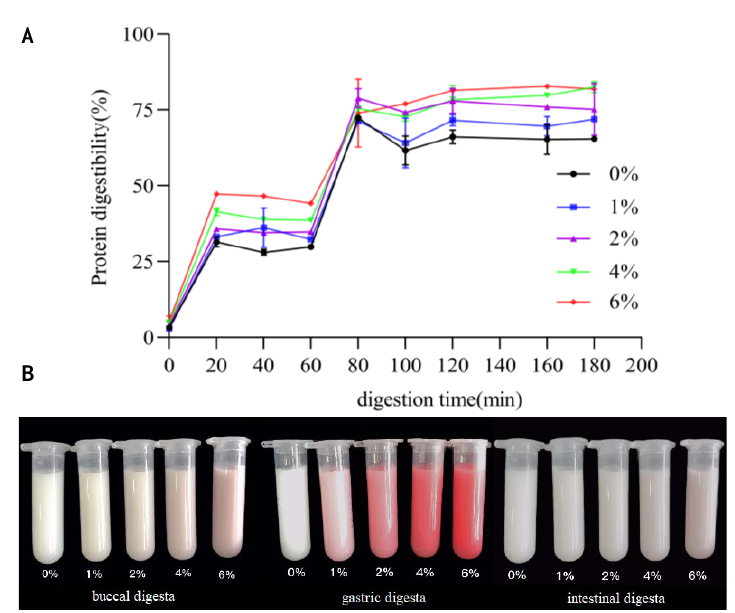
Figure 3. Protein digestibility ( A ) and visual appearance ( B ) of FGM supplemented with BHJ during in vitro digestion.